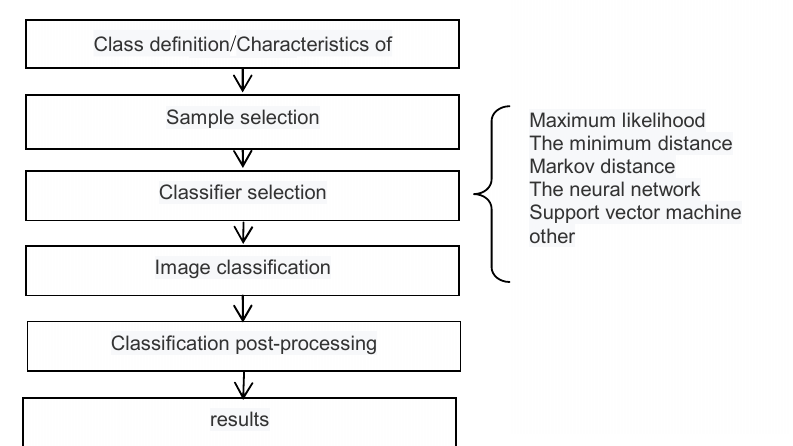
shown in figure 4-1 (a) for the surface profile in 2010, guilin, figure 4-1 (b) for the surface profile in 2013, guilin, figure 4-1(c) for the surface profile in 2016, guilin, figure 4-1 (d) is displayed on the image to extract the surface profile of guilin in 2013, figure 4-1 (e) for enlarged lijiang river interchange of